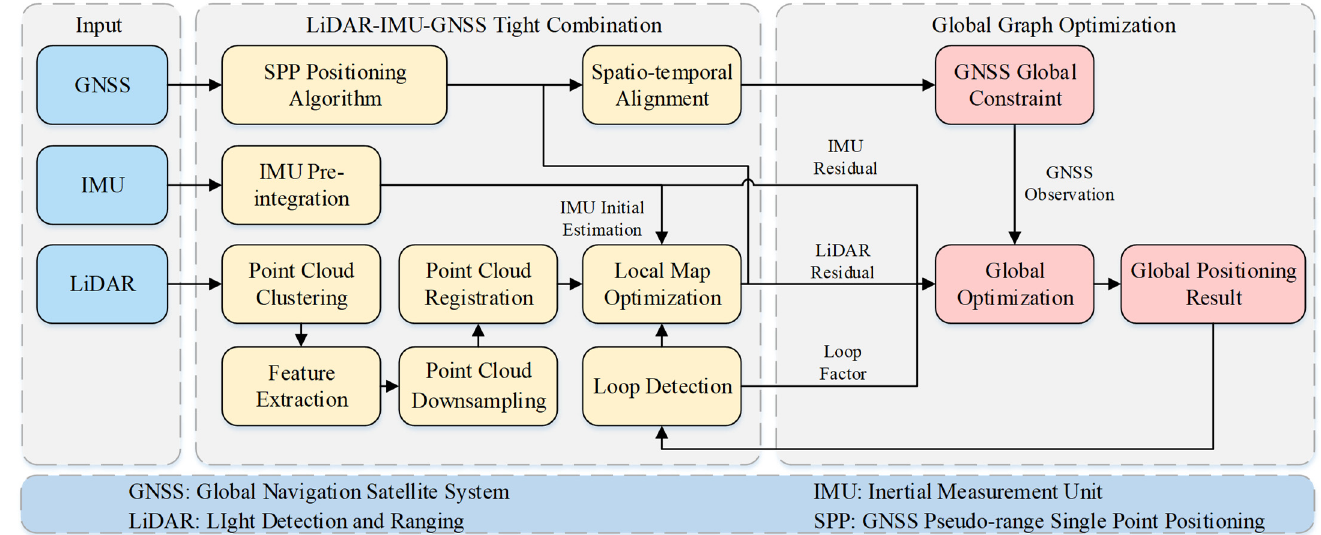
Figure 1. General framework of the algorithm. LIO’s pose estimation results are used as local optimization factors, and GNSS pseudo-range single point positioning (SPP) results are used as global optimization factors for global constraint.